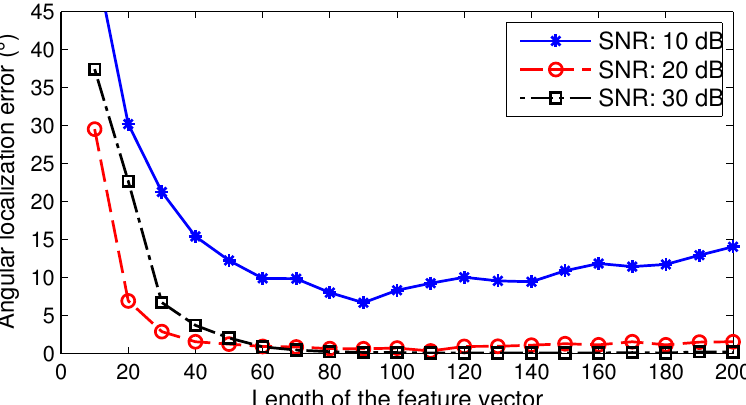
Figure 6. Localization error with respect to feature vector